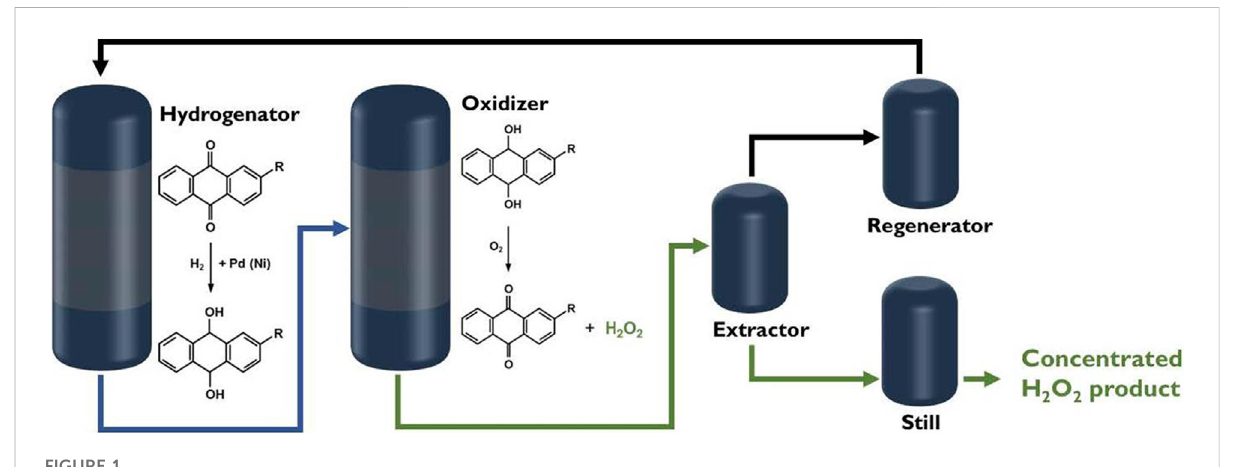
FIGURE 1 Flow chart of synthesis of H 2 O 2 by AQ method (Yang et al.,